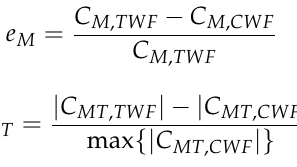
Figure 16. Relative errors of ( a ) C M and ( b ) C MT between CWFs and TWFs.